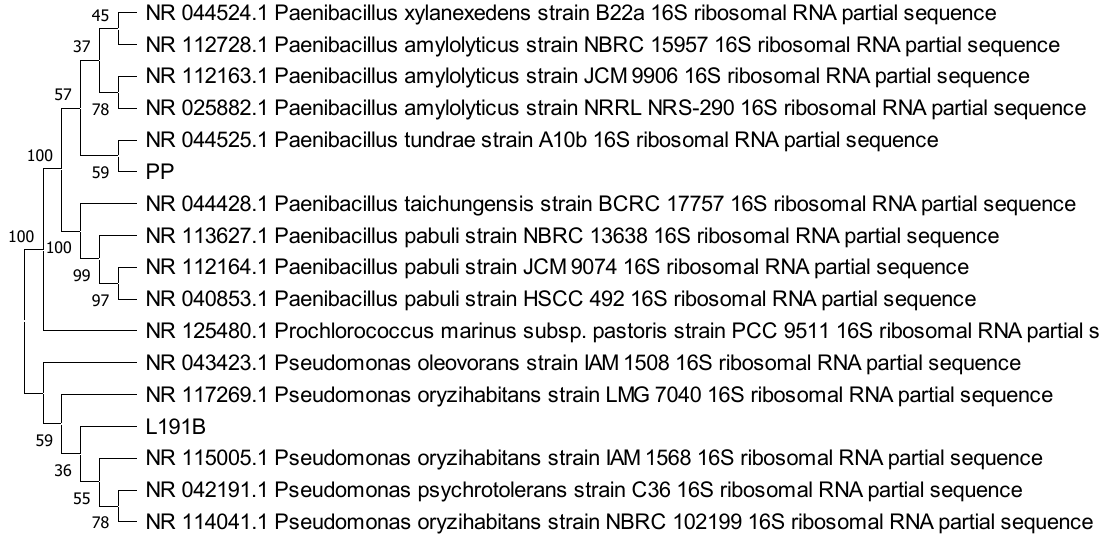
Figure 2. Phylogeny tree based on the neighbor joining method [44] using 16S rRNA gene partial sequences of bacteria from this study (L191B and PP), as well as bacteria that were genetically closest ( ≥ 97% Identity) and cyanobacteria Pro- chlorococcus marinus as an outgroup. Branch length is 0.29527974. Bootstrap values (%) after 1000 iterations are shown next to the branches [45].